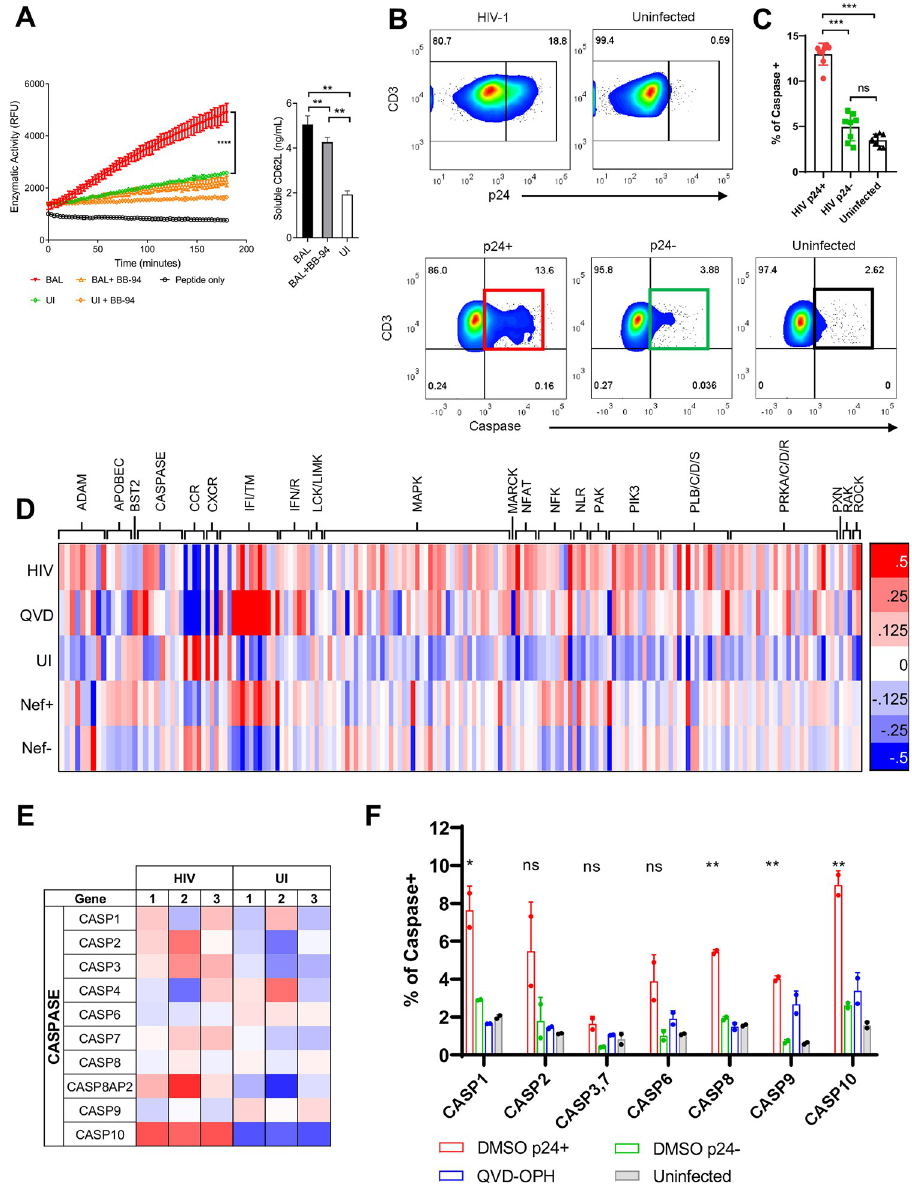
Fig 1. HIV-1 infection activates caspases and sheddases. (A) (Left panel) Enzymatic cleavage of a membrane proximal CD62L peptide by cell membrane-associated proteases isolated from day 6 HIV-1 BAL infected (BAL) or uninfected (UI) CD8-depleted PBMC in the presence and absence of 20 μ M BB-94. The data are from technical duplicates and the results are representative of two independent experiments. (Right panel) ELISA measurement of soluble CD62L concentration from the infected (BAL) and uninfected (UI) culture media. The statistics are analyzed using technical repeats in a two-tailed student t-test for each experiment with p values < 0.01 ( �� ), p < 0.0001 ( ���� ). (B) Flow cytometry analysis of caspase activation in CD4+ T cells from HIV-1 BAL infected or uninfected PBMC on day 6 of post infection. The cells are stained for intracellular viral capsid protein p24 (top) and activated caspases in p24 + vs p24- T cells (bottom). T cells with activated caspases in p24+ and p24- populations as well as in the uninfected sample are highlighted in red, green and black squares, respectively. (C) Bar diagram showing caspase activation in p24 + (red), p24- (green) populations of the infected sample as well as the uninfected control (black). Caspase activation correlated with CD62L and CD4 loss (S1B Fig). Mann-Whitney nonparametric test ��� p < 0.001. The results are representative of three independent experiments. (D) Differential gene expressions between infected and uninfected CD4+ T cells from representative transcriptome analyses by RNA-Seq. HIV, QVD and UI denote cells infected with HIV-1 BAL in the absence or presence of QVD-OPH, or uninfected sample. Nef +/- samples are cells infected with Nef- sufficient or -deficient strains of HIV-1 NL4-3 . HIV-1 BAL infection elevated the expressions of many genes involved